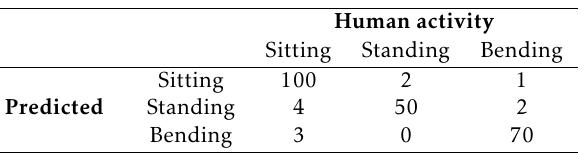
Tab 3. Example about evaluation parameters with sitting, standing, and